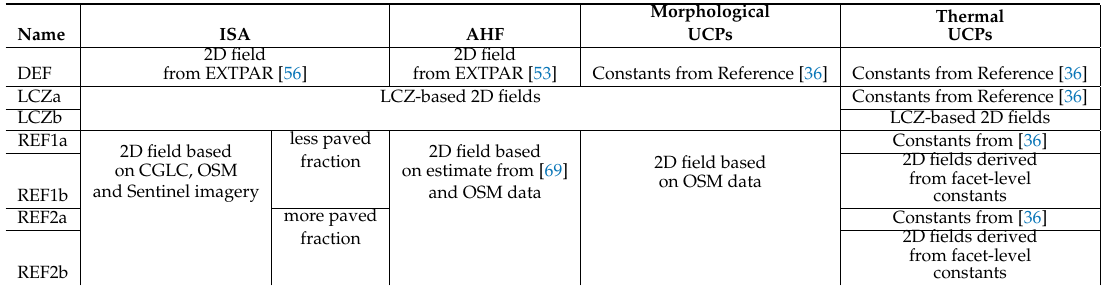
Table 1. Summary of the urban canopy parameters (UCPs) datasets, used in numerical